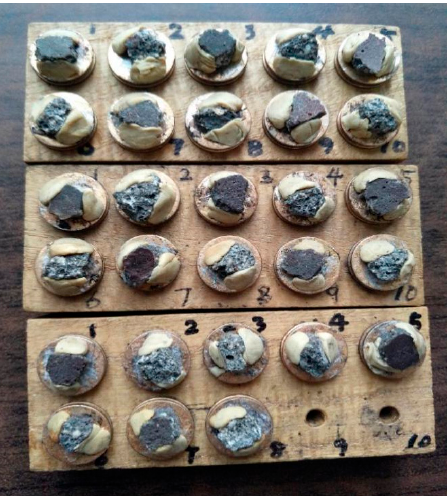
Figure 4. Crushed specimens immersed for 0 d, 30 d, and 50 d polymer concrete (PC).